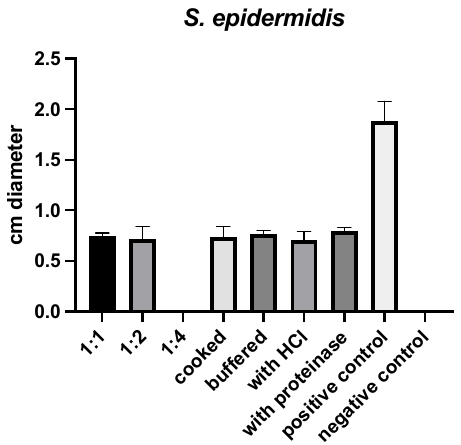
Figure 1. Results of susceptibility testing with (S)-reutericyclin.